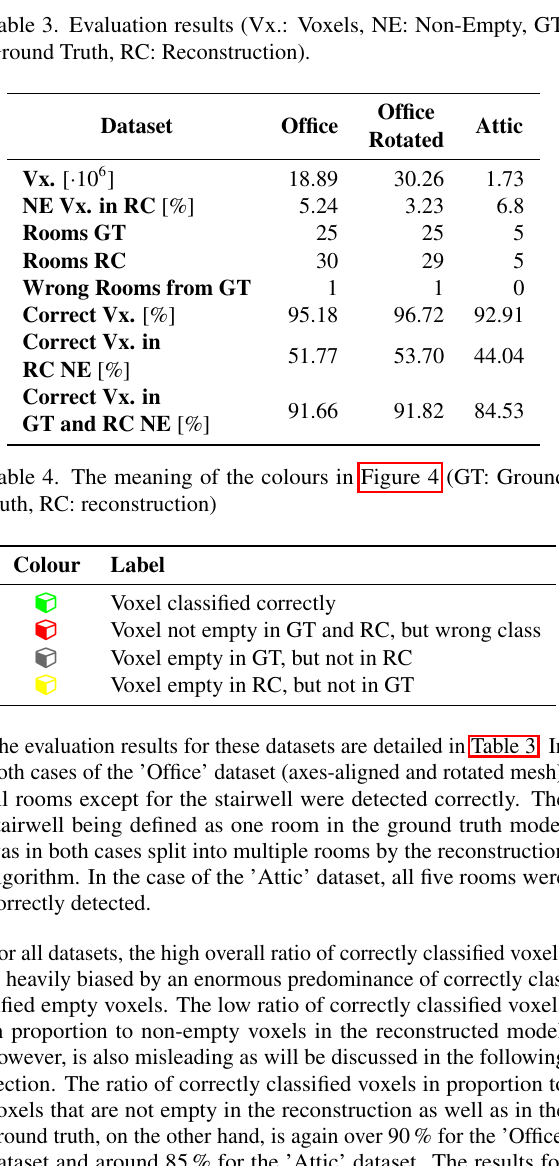
Table 3. Evaluation results (Vx.: Voxels, NE: Non-Empty, GT: Ground Truth, RC: Reconstruction).